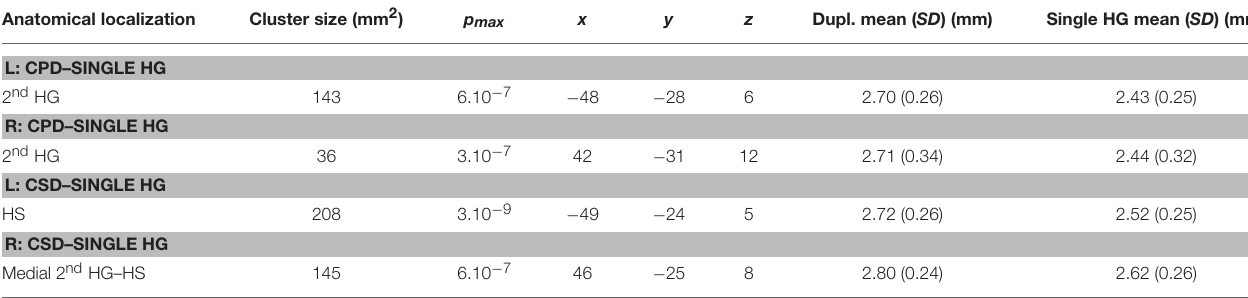
TABLE 3 | Local variations of Cortical Thickness (CT) detected in “CPD–single HG”, “CSD–single HG” and “CPD–CSD” contrasts. Anatomical